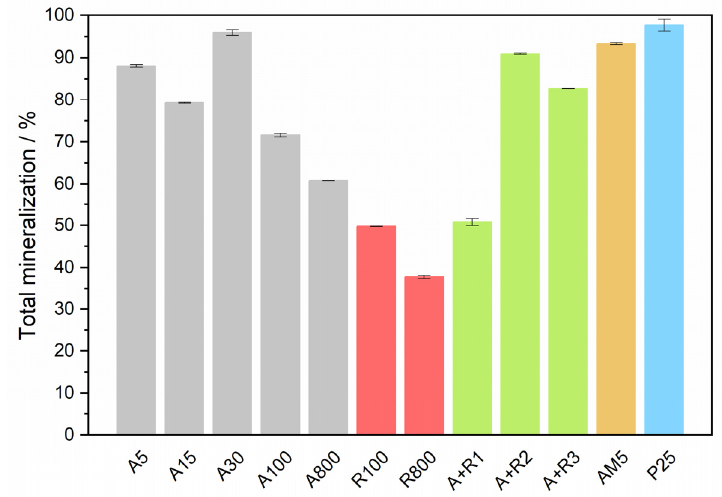
Figure 4. Degree of mineralization of ampicillin after long-term irradiation of 26 h .